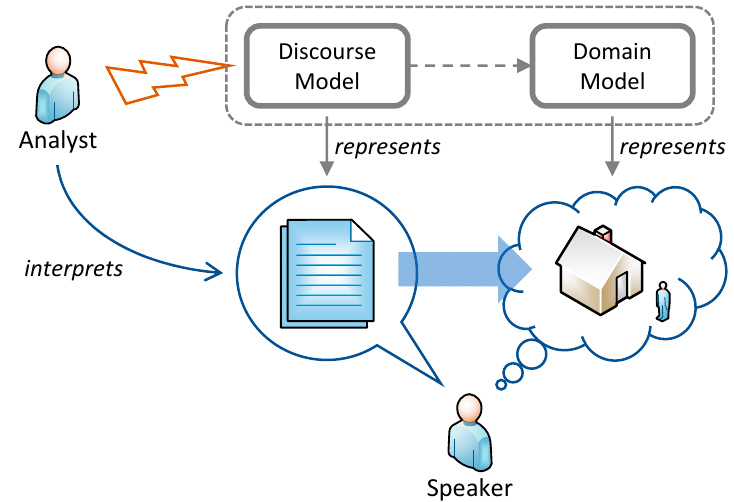
Figure 1. A speaker produces a discourse (centre) referring to a part of the world in their mind (right-hand side). By looking only at the discourse, an analyst creates a discourse model to represent the discourse, plus a domain model to represent the associated domain. Since the discourse refers to the domain (thick arrow, bottom), the discourse model must somehow refer to the domain model (dashed arrow, top).